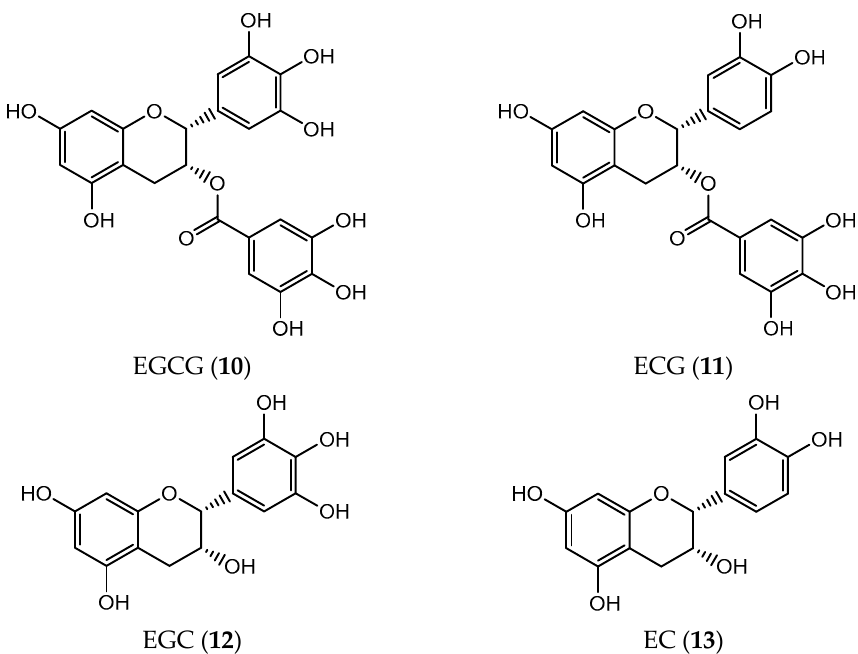
Figure 3. Natural catechins isolated from green tea with antitumor activity.